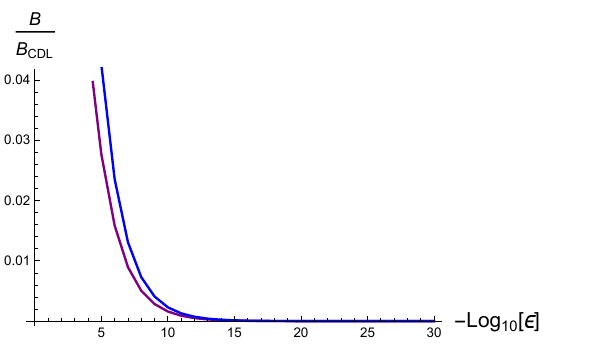
Figure 8 . The ratio B=B CDL as a function of (cid:15) for (cid:12)xed (cid:14) = 6 = 10. The purple and blue curves correspond to c 1 = 1 = 100 and c 1 = 1 =